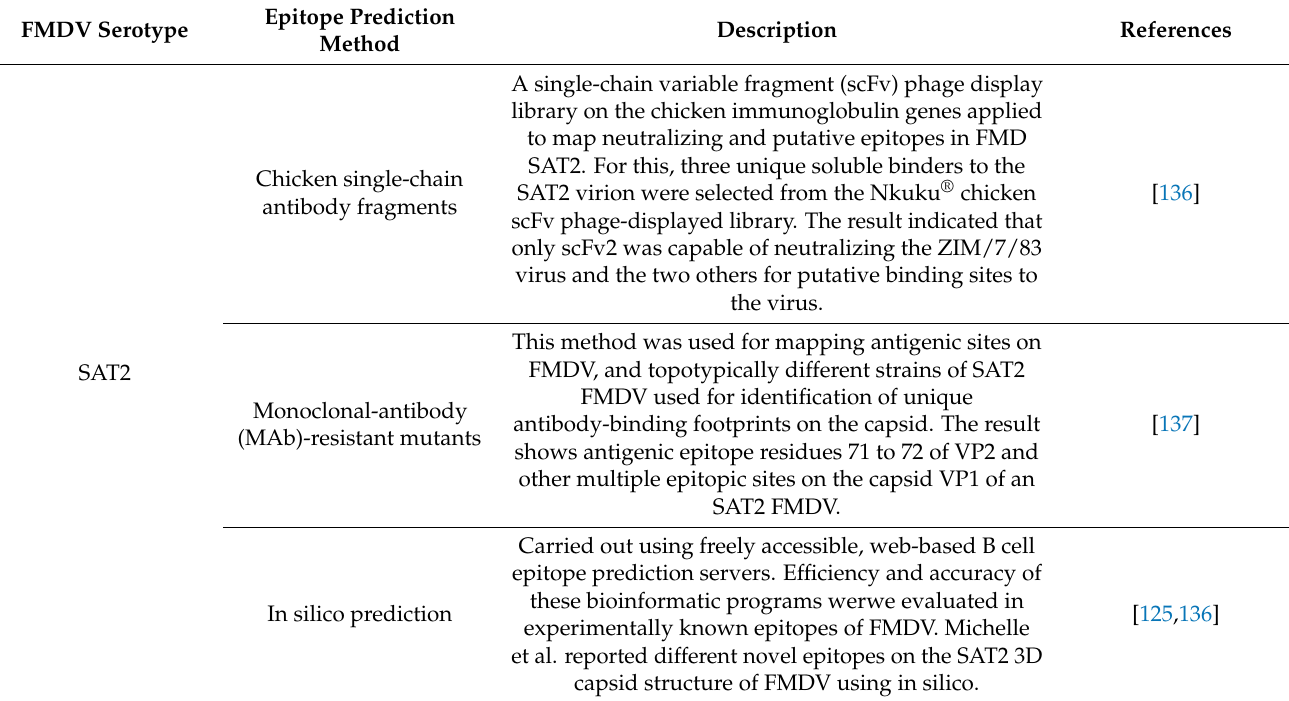
Table 4. Methods used for prediction of epitope regions in FMDV serotype